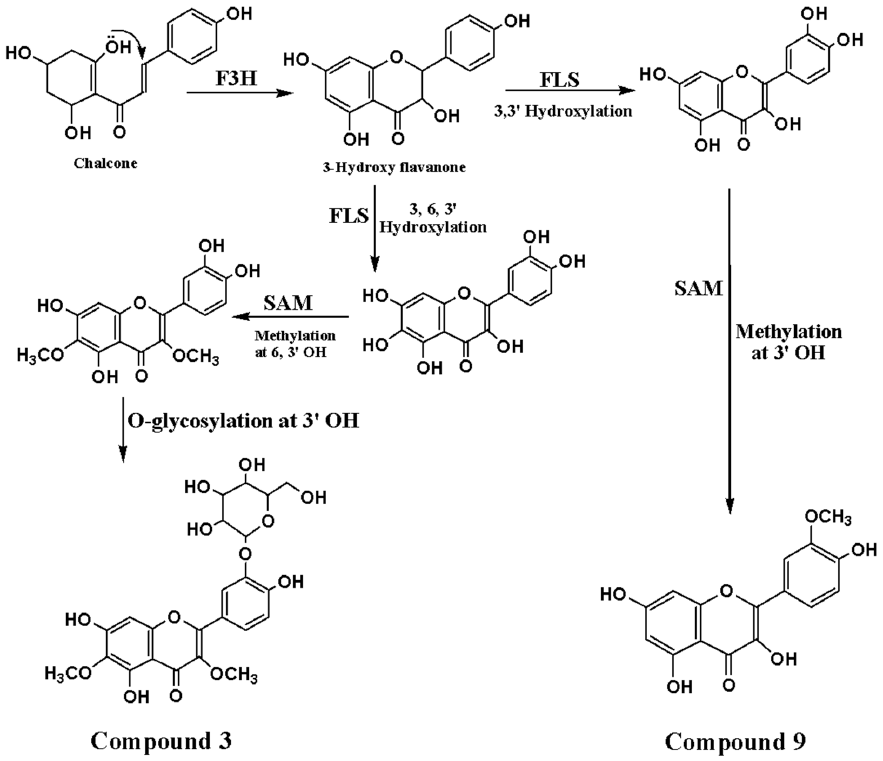
Figure 5. Proposed biosynthesis pathway scheme for the isolated methoxyled flavones.